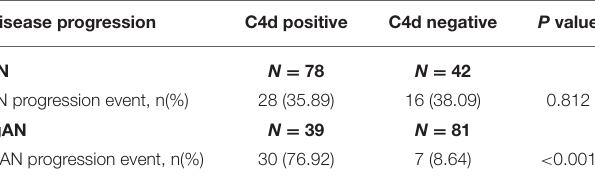
TABLE 5 | Relationship between renal C4d deposition with the disease progression of LN and IgAN patients during the follow-up period. Disease